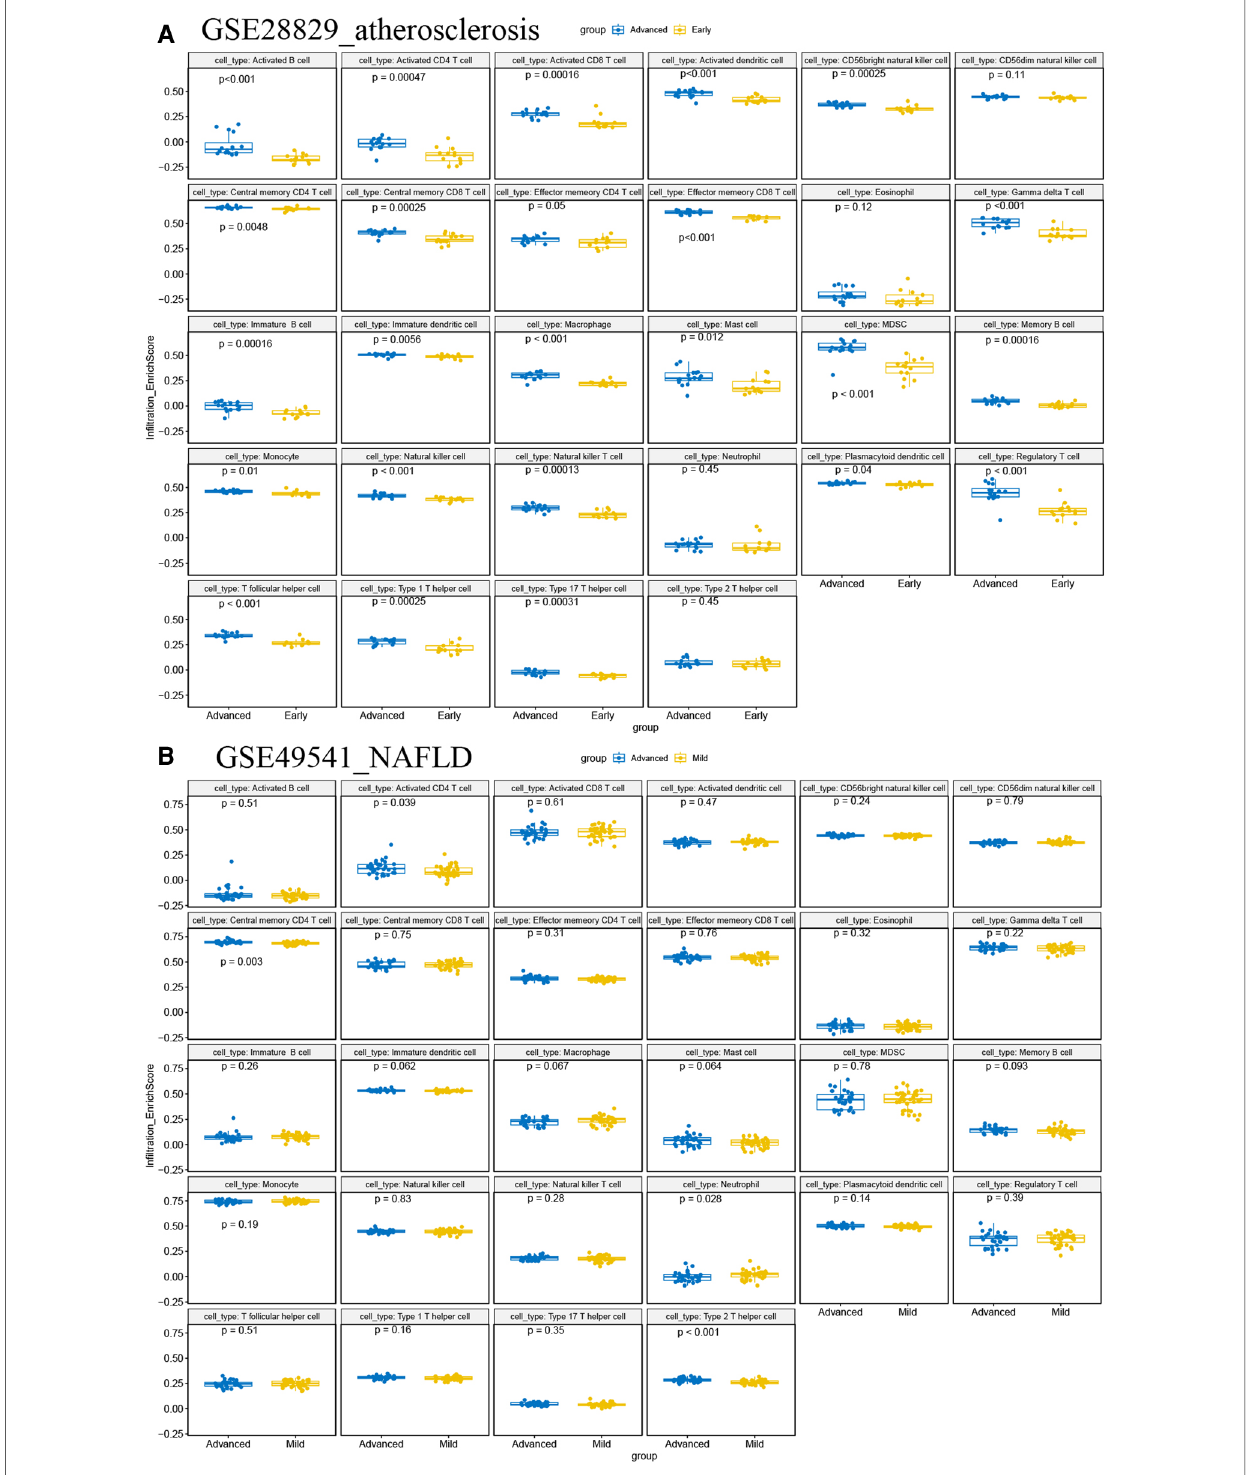
FIGURE 12 ssGSEA for immune in fi ltration. ( A ) The boxplots of 28 immunocyte subtypes between advanced and early AS in GSE28829; ( B ) the boxplots of 28 immunocyte subtypes between advanced and mild NAFLD in